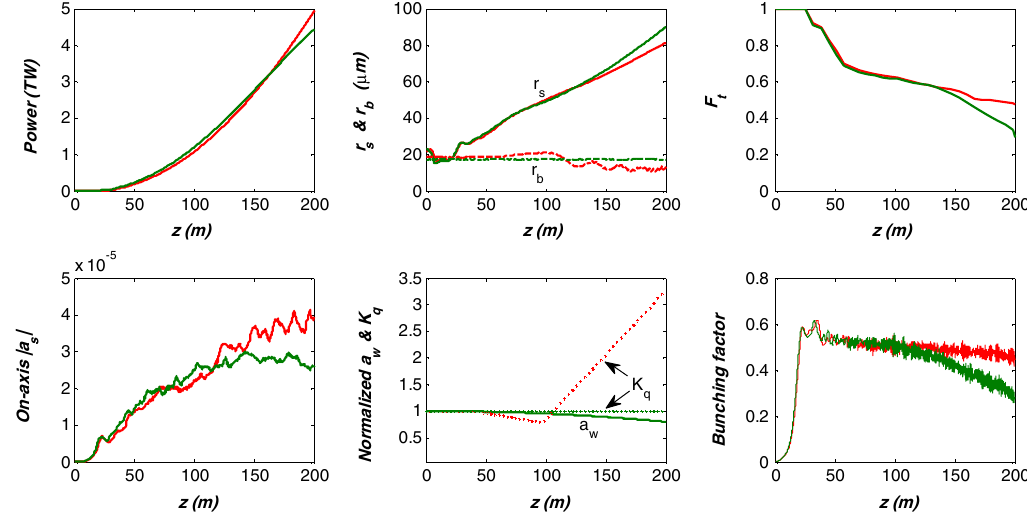
j , r , F , and bunching factor in a s s t (red lines). The taper profile is obtained from b